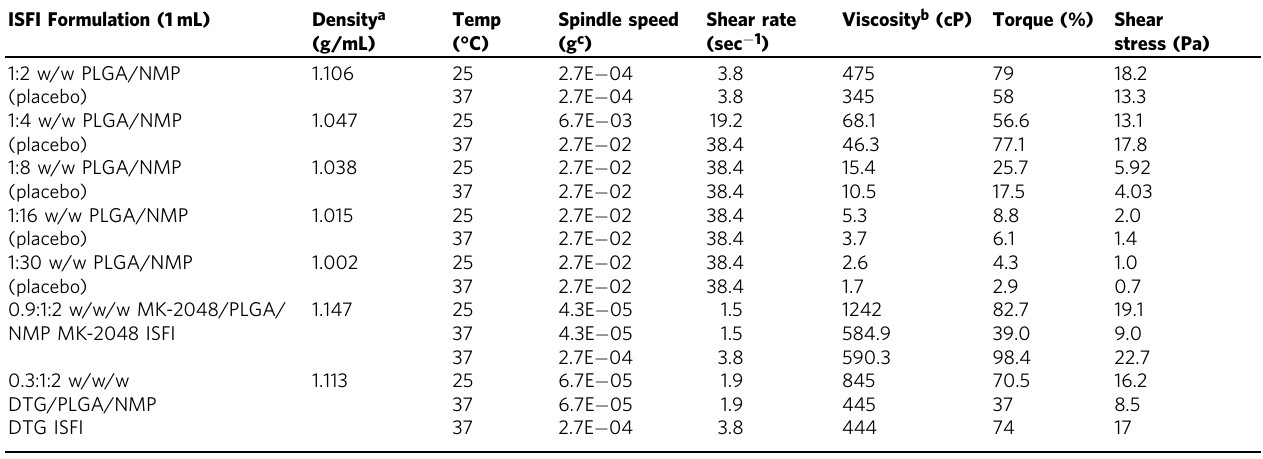
Table 1 Density and rheology of ISFI formulations ISFI Formulation (1 mL) Density